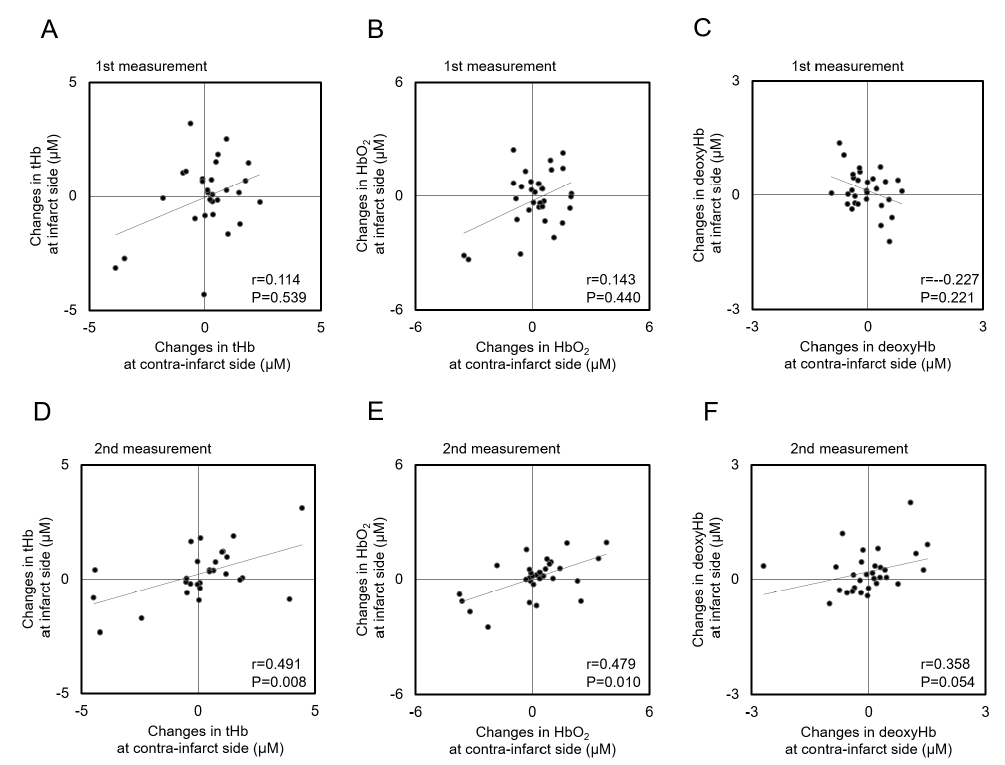
Figure 5. Scatterplots of the changes in total-hemoglobin (tHB), oxygenated-hemoglobin (HbO 2 ), and deoxygenated-hemoglobin (deoxyHb) concentrations in response to head-of-bed elevation (from 0° to 30°) at the first ( A – C ) and second ( D – F ) measurements for each hemisphere.